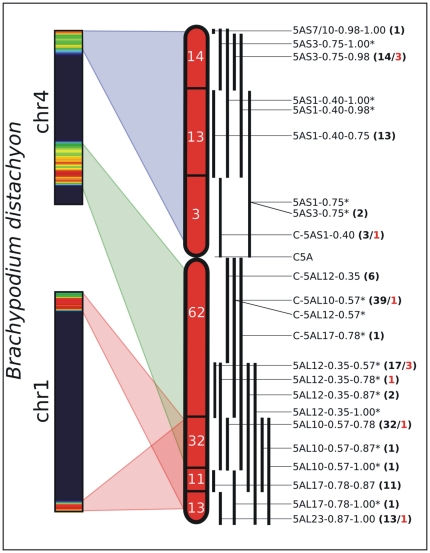
Integration between wheat chromosome 5A virtual gene order and its physical map.The integration was achieved by anchoring the wheat genes positioned along the genome zipper with the EST markers. The figure shows the Brachypodium syntenic regions. The white numbers on the wheat chromosome represent the number of EST markers anchored to the corresponding bin (on the right) showing homology with the zipper genes. In case of overlapping bins the numbers were summed. The black numbers between parentheses beside each bin name indicate how many ESTs are anchored on that specific bin. Red numbers indicate genes anchored on the wrong arm with respect to the origin of the reads.